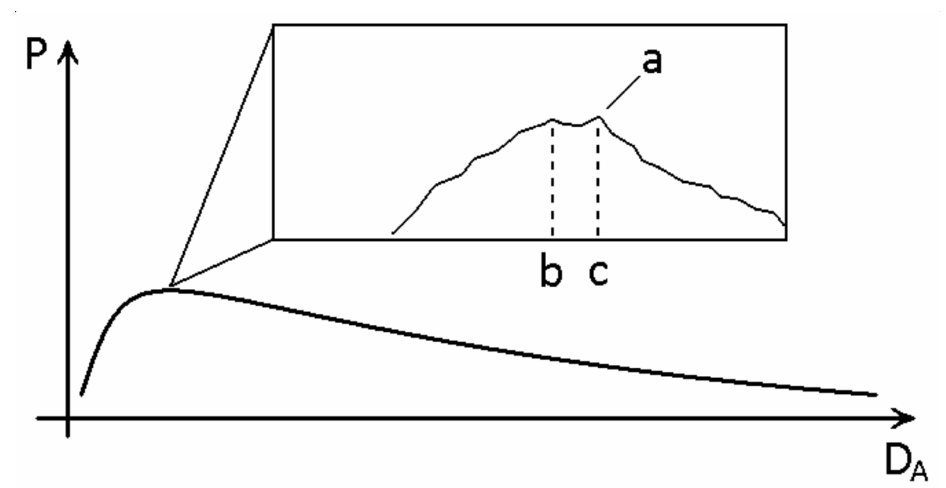
Figure A7. Impact of fluctuations in the power curve on the identification of the duty cycle at the maximum power point. ( a ) A power fluctuation. ( b ) Duty cycle at the actual maximum power point. ( c ) Duty cycle at the fluctuation.